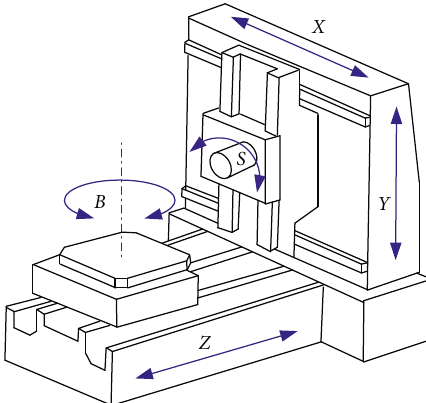
Figure 2: Structure schematic of the multiaxis machine tool. Table 1: Geometric error terms of the four-axis machine tool. Errors sources